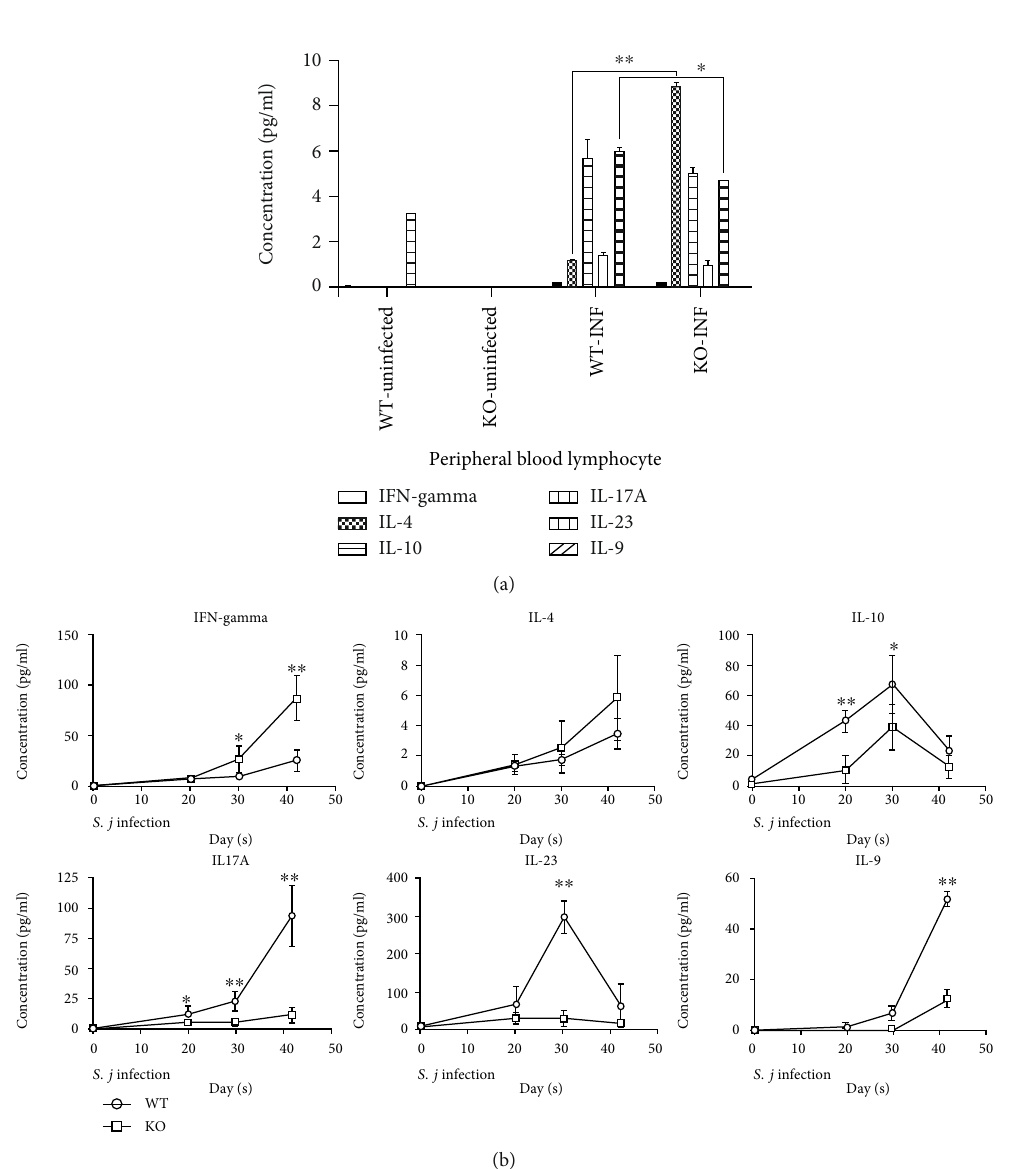
Figure 7: Serum cytokines in USP21 fl / fl FOXP3 Cre mice infected with S. japonicum . (a) Comparison of the concentrations of IFN- gamma, IL-4, IL-10, IL-17A, IL-23, and IL-9 in the cultures of peripheral blood lymphocytes isolated from the WT and KO mice in the NC and INF groups 42 days after the infection ( n = 10 mice/group). The data are presented as the means ± SD , IL-4 ∗∗ p = 0 : 008 , and IL-23 ∗ p = 0 : 035 for the comparison between the infection groups. (b) Comparison of the serum IFN-gamma, IL-4, IL-10, IL- 17A, IL-23, and IL-9 levels in the WT- and KO-INF groups ( n = 26 ± 2 /group) at di ff erent time points (uninfected, 20 th day after infection, 30 th day after infection, and 42 nd day after infection). The data are presented as the means ± SD . IFN- γ ∗ p = 0 : 024 on day 20 and ∗∗ p < 0 : 001 on day 42; IL-10 ∗∗ p < 0 : 001 on day 20 and ∗ p = 0 : 017 on day 30; IL-17A ∗ p = 0 : 026 on day 20, ∗ p < 0 : 001 on day 30, and ∗∗ p < 0 : 001 on day 42; IL-23 ∗∗ p < 0 : 001 on day 30; and IL-9 ∗∗ p < 0 : 001 on day